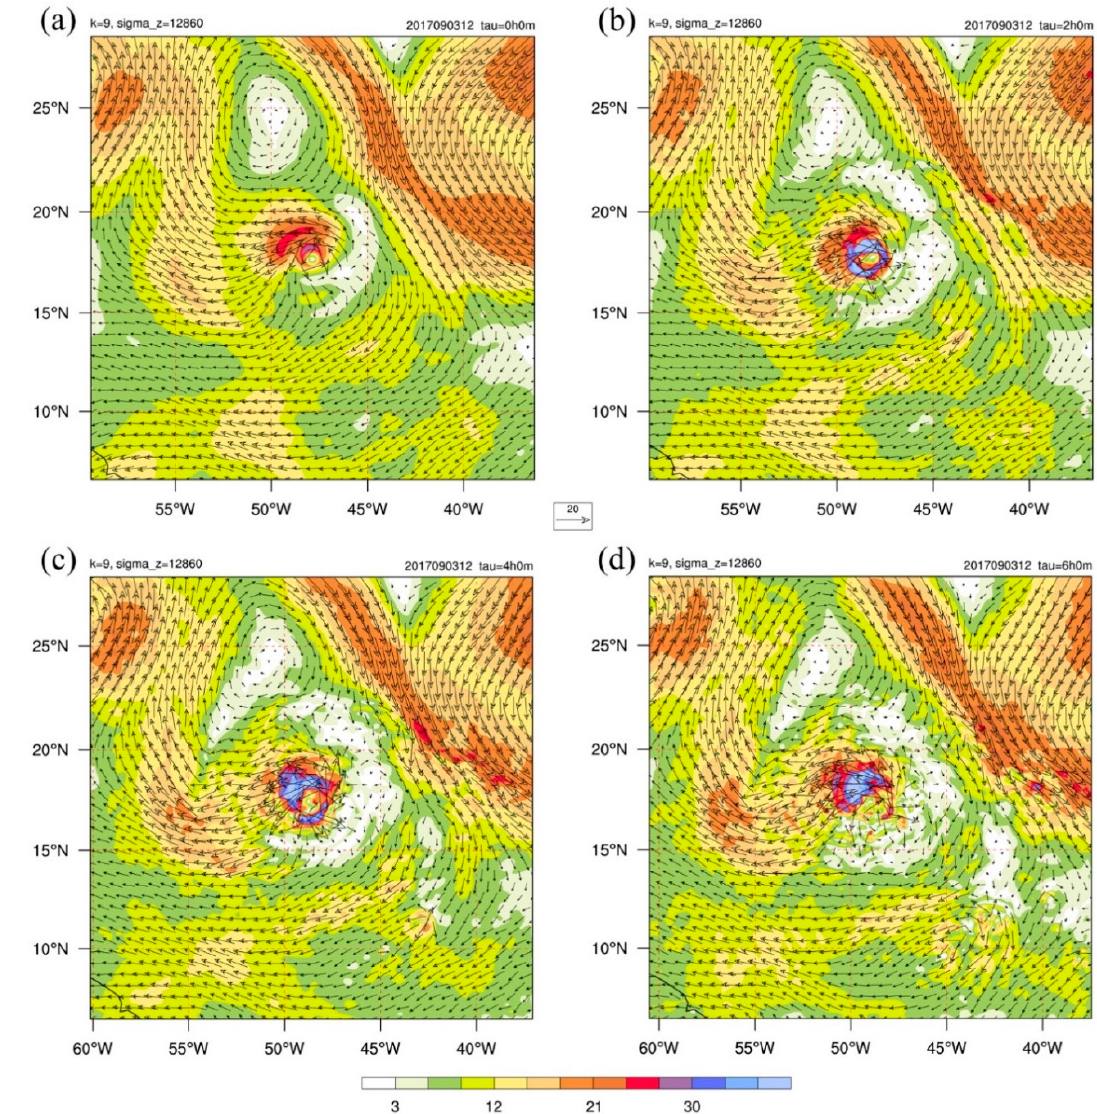
Figure 6. Domain 3 FCDI analyses of z = 12,860 m wind vectors (m s − 1 ; color bar at bottom and 20 m s − 1 length indicated by arrow in middle) starting from cold-start COAMPS-TC wind vectors in panel ( a ) and then 15 min AMV-based FCDI analyses at ( b ) tau = 2 h, ( c ) tau = 4 h, and ( d ) tau = 6 h.